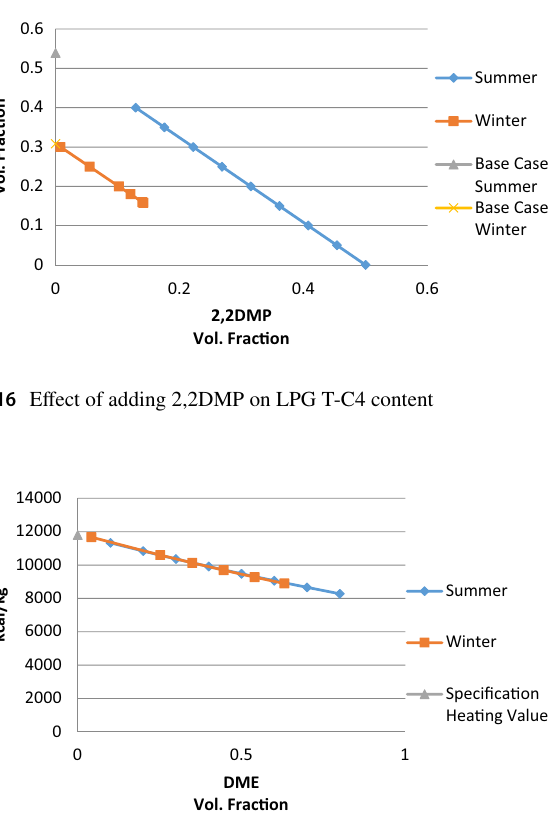
Fig. 17 Effect of adding DME on LPG heating value